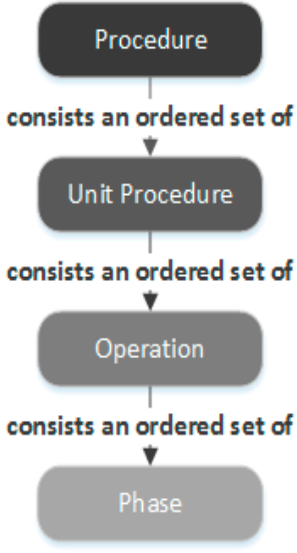
Figure 9. ISA-88 procedure model.